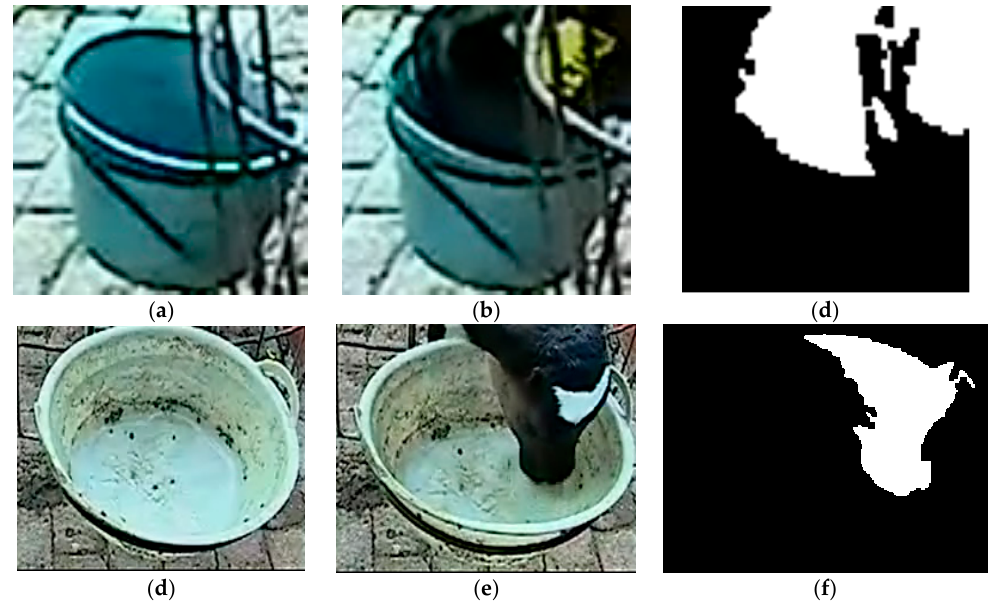
Figure 8. Feeding-basin and drinking-basin areas. ( a ) Feeding basin; ( b ) Calf feeding; ( c ) Result of binary image acquisition; ( d ) Drinking basin; ( e ) Calf drinking; ( f ) Result of binary image acquisition.